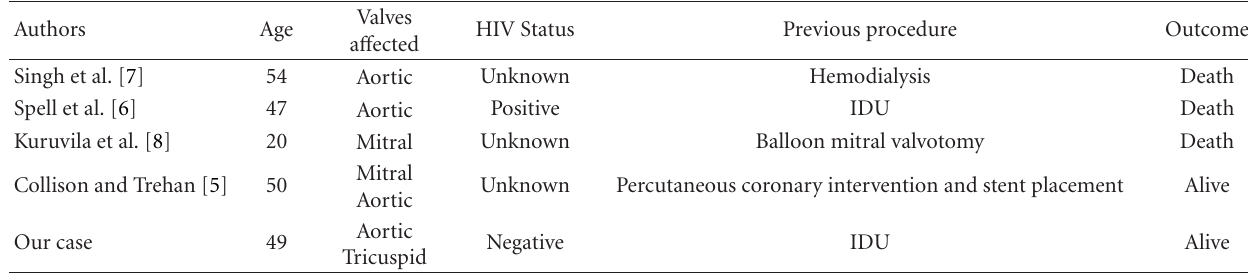
Table 1: Summary of previously published cases of M. fortuitum native